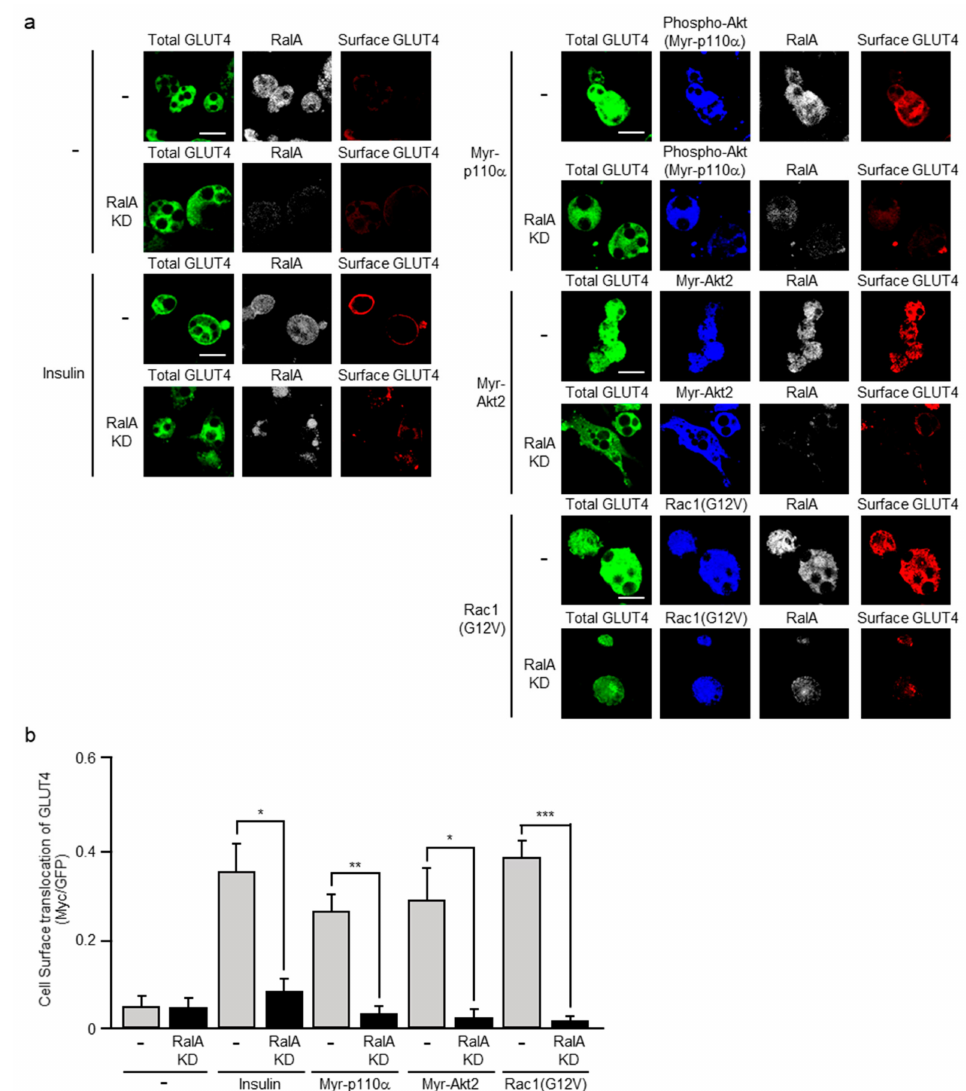
Figure 7. E ff ect of RalA knockdown on GLUT4 translocation induced by insulin or a constitutively activated mutant of PI3K, Akt2, or Rac1. ( a ) L1-GLUT4 adipocytes were infected with the control (-), Myr-p110 α -expressing, Myr-Akt2-expressing, or Rac1(G12V)-expressing virus. The total amount of GLUT4 myc 7-GFPwasestimatedbythefluorescenceofGFP.TheexpressionofMyr-p110 α wasmonitored by immunofluorescent microscopy using an anti-phospho-Akt antibody. Myr-Akt2 and Rac1(G12V) were visualized by immunofluorescent microscopy using an anti-HA antibody. Endogenous RalA was visualized by immunofluorescent microscopy using an anti-RalA antibody. Cell surface-localized GLUT4 myc 7-GFP was visualized by immunofluorescent microscopy using an anti-Myc antibody. Scale bar, 50 µ m. ( b ) Cell surface translocation of GLUT4 myc 7-GFP shown in (a) was quantified. Data are shown as means ± S.E. ( n = 10). * p < 0.05; ** p < 0.01; *** p <